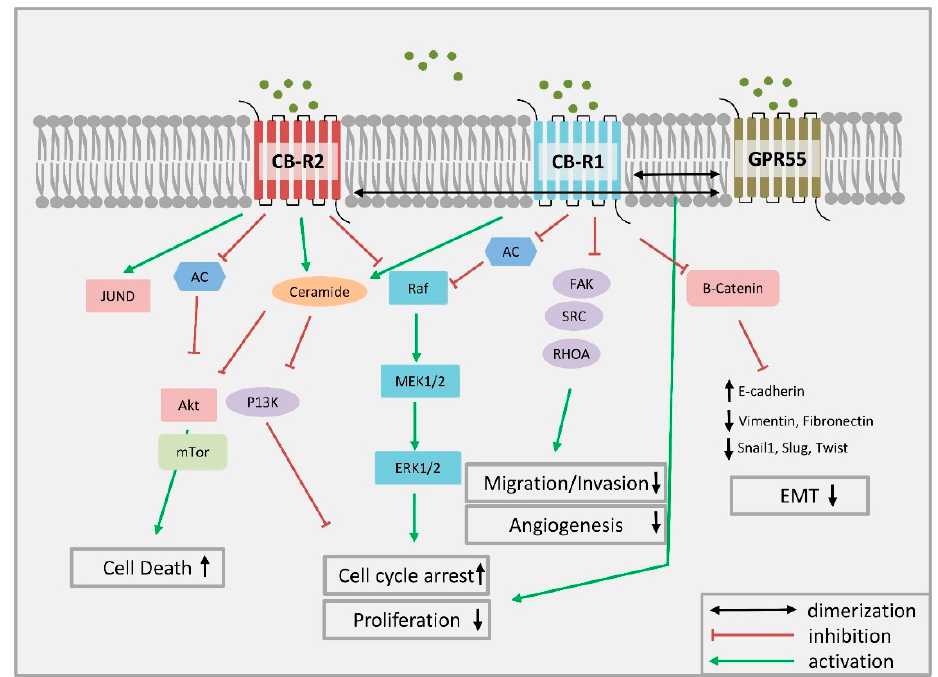
Figure 2. Mechanism of CB-R-mediated antitumor activity in breast cancer cells. By binding to CB1-R and CB2-R, CBs inhibit breast cancer cell proliferation through various mechanisms. They block cell cycle progression at the G1/S phase via CB1-R and at the G2/M phase via CB2-R activation. They induce breast cancer cell death via apoptosis, mediated by the activation of the transcription factor jun-D. In HER2-overexpressing breast cancer cells, they block cancer cell proliferation in culture and tumors by inhibiting Akt and ERK signaling. They also inhibit cell migration and angiogenesis via CB2-R. CB1-R activation inhibits the FAK/SRC/RhoA pathway leading to inhibition of cell migration. Cell migration blockade is also achieved by CB2-R activation through the inhibition of COX-2 and ERK signaling, which is important for triple-negative breast cancer. AC: adenylate cyclase; Akt: protein kinase